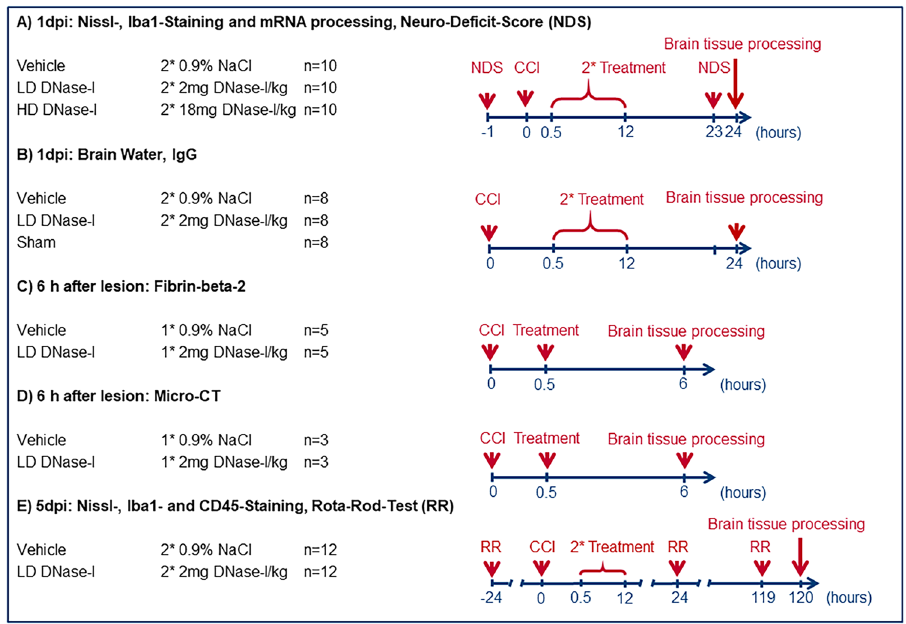
Figure 5. Study design. Overview of the different experiments performed separately with the respective dosage of DNase-I and number of animals. First, lesion volume 1 day post injury (1 dpi) was determined after using different doses of DNase-I and vehicle. Brain tissue from the same cohort was used to perform qPCR. The experiments in sections B, C, D, and E were continued only with the effective low dose of DNase-I (LD DNase-I vs. vehicle and/or